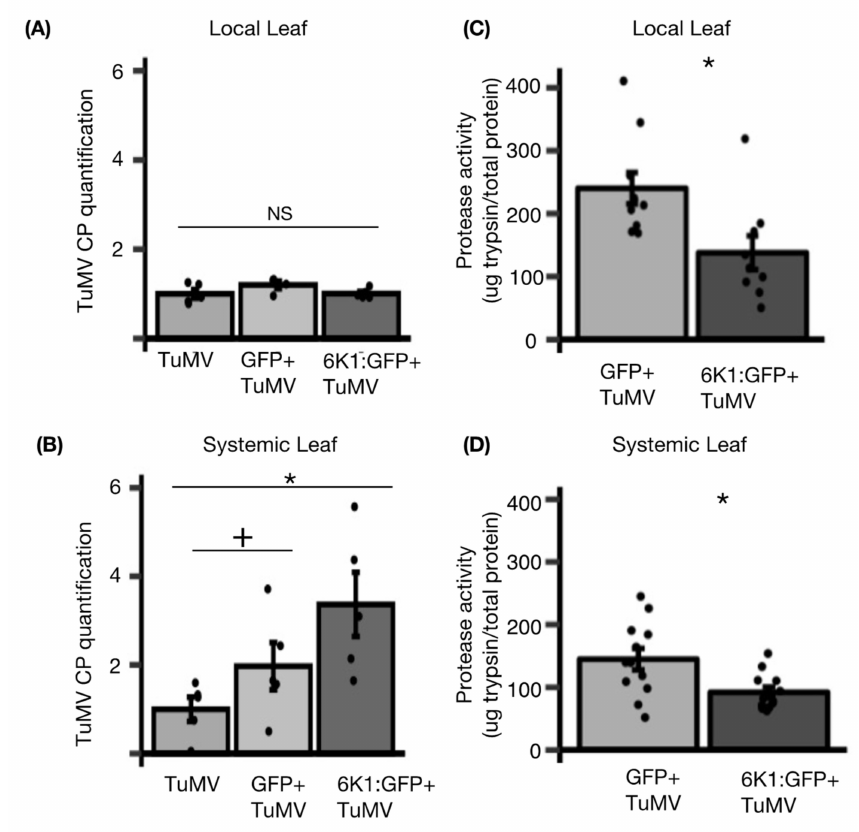
Figure 5. 6K1:GFP expression inhibits plant protease activity in infected plants and increases TuMV accumulation in systemic leaves. ( A , B ) GFP or, 6K1:GFP constructs were co-infiltrated with TuMV into N. benthamiana leaves. In the control treatment, only TuMV was agro-infiltrated. At 60 h post infiltrations, CP gene-specific primers were used for the quantification of viral RNA relative to the actin in the local ( A ) and systemic leaves ( B ). ( C , D ) In a separate experiment GFP and 6K1:GFP were agroinoculated into local leaves with TuMV ( C ) or in systemically infected leaves ( D ) and protease activity measured. Significance was determined using differences at a p -value of * < 0.05 and + < 0.1 as determined from a least significance difference (LSD) test ( n = 5, mean ± SE; GLM performed for A and B ; n = 10, mean ± SE; one-way ANOVA for C and D ). NS indicates non-significant (1